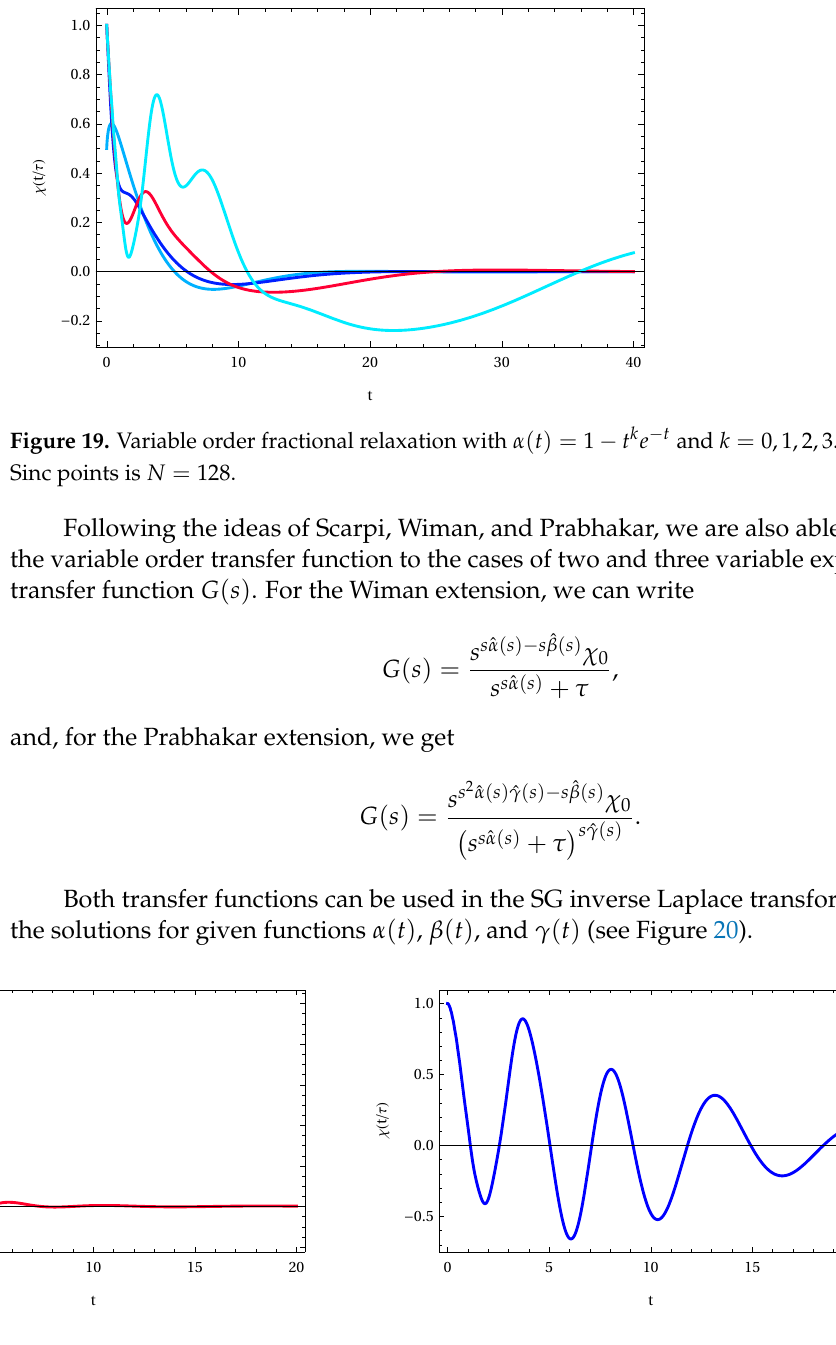
Figure 20. Extensions of Scarpi’s fractional equation. Left panel α ( t ) = 1 panel the same functions for α ( t ) and β ( t ) as in the left panel, but γ ( t ) = sin ( t ) and N =